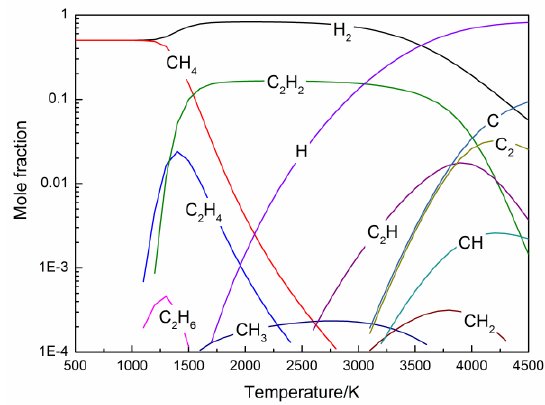
Figure 3. The equilibrium composition of H–C system (H/C = 6.0).